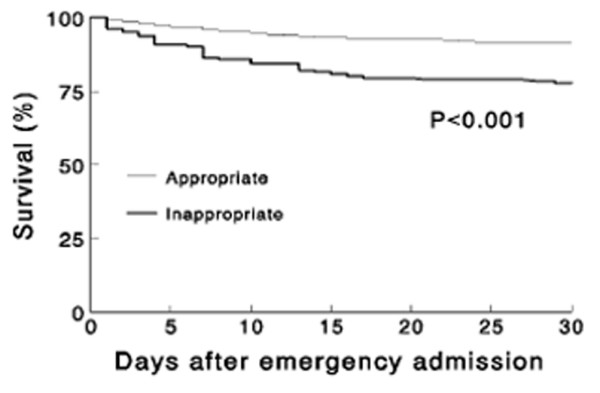
Kaplan-Meier estimates of survival according to the initial treatment received in the emergency department. Inappropriate treatment was noted in 162 (32%) of the 514 patients. The log-rank test was used to calculate p.